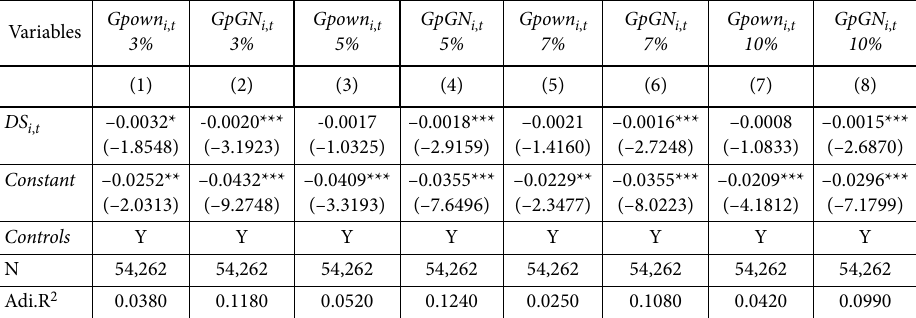
Table 11. Adjustments to the definition of long